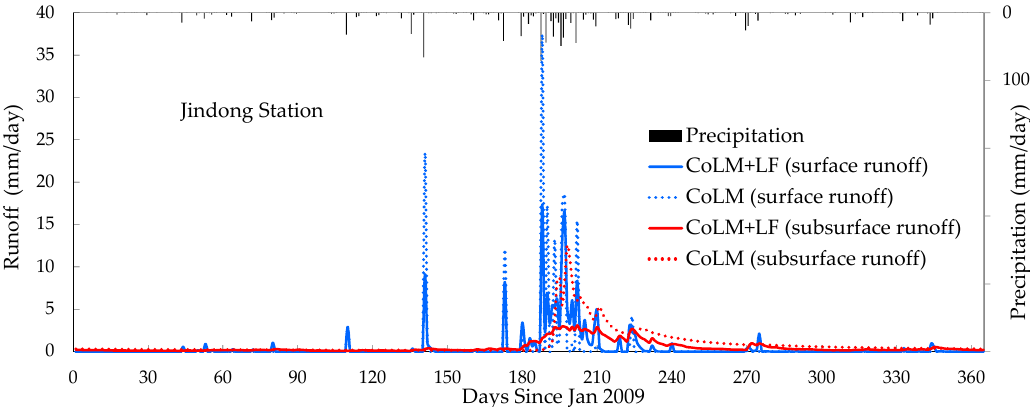
Figure 9. Comparison of daily time series of surface runoff and subsurface runoff simulated from the baseline CoLM and the new CoLM+LF under each calibrated parameter set at the Jindong stream gauge station in 2009. The observed hyetographs of total precipitation averaged for the study watershed are presented along the secondary vertical axis.